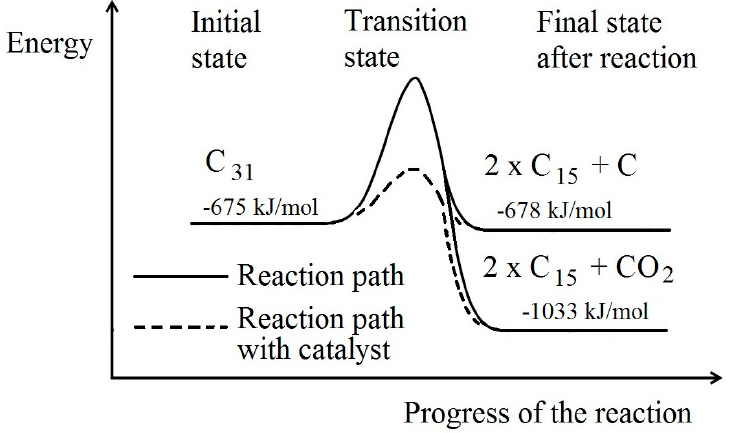
Figure 5. Schematic diagram illustrating the possible breakdown of C 31 to C 15 without oxidation and (lower line) with oxidation.